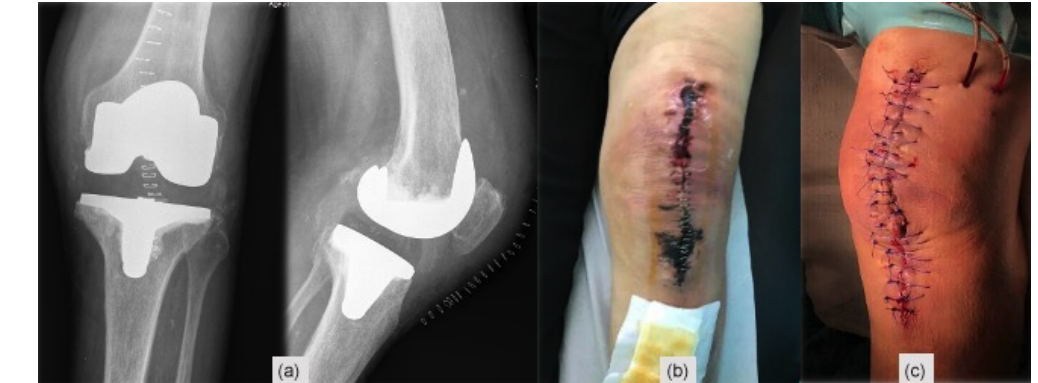
Figure 1. (a) Post-operative TKA X-ray, (b) skin necrosis on the 18th post-operative day, and (c) surgical wound immediately after debride- ment and antibiotics with implant retention (DAIR).